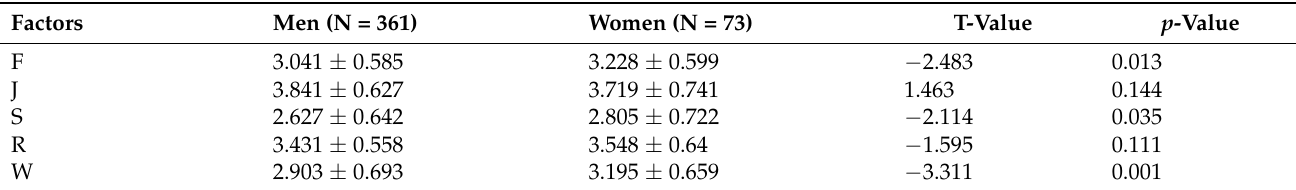
Table 5. Differences in Gender on Various